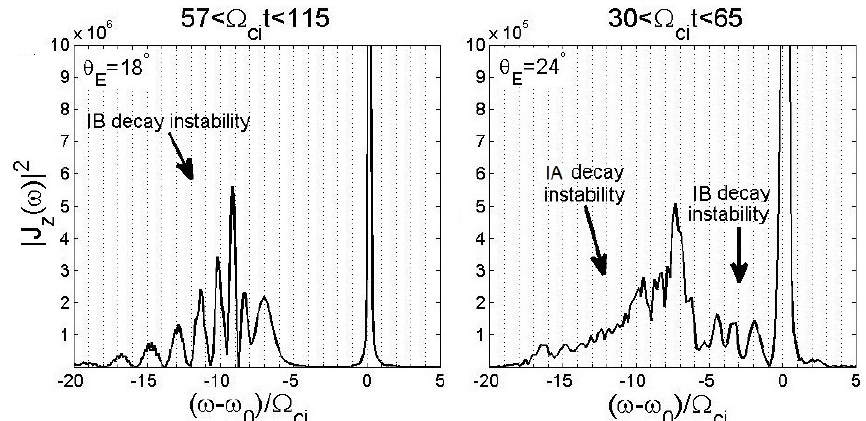
Fig. 4. Power spectrum of simulated current density along the magnetic field taken over time ranges corresponding to IB/IA parametric decay for θ E = 18 ◦ shows discrete ion gyro-harmonic structures and for θ E = 24 ◦ shows broadband oblique IA spectral feature.